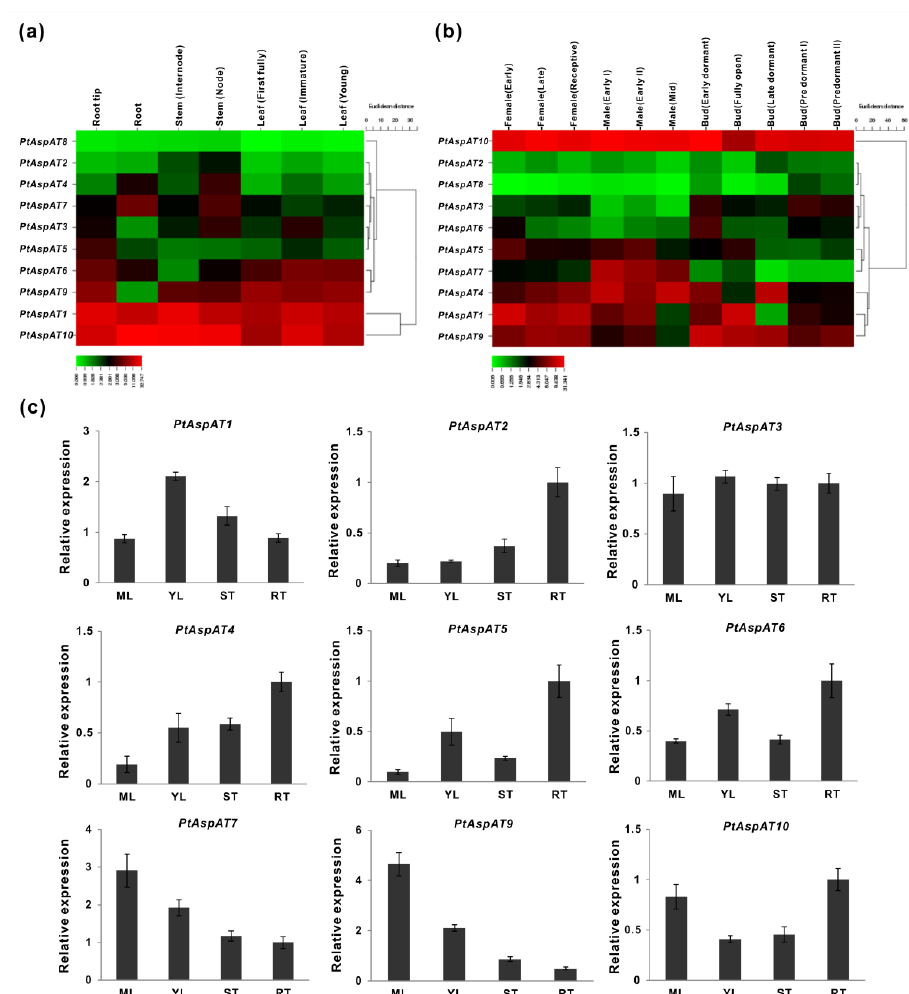
Figure 5. Expression profiles of AspATs in various tissues of P. trichocarpa . ( a , b ) Transcriptomic analyses in heat map showing the transcript abundance of PtAspATs in vegetative and reproductive tissues. ( c ) Tissue-specific expression of PtAspATs in ML (mature leaf), YL (young leaf), ST (stem), and RT (root). The RNA-seq results were given in FPKM (fragments per kilobase per million reads) expression values. Data represent mean values ± standard error (SE) of at least three independent biological replicates for qRT-PCR. PtActin , PtUBIC , and PtEF1 α were used as reference genes.